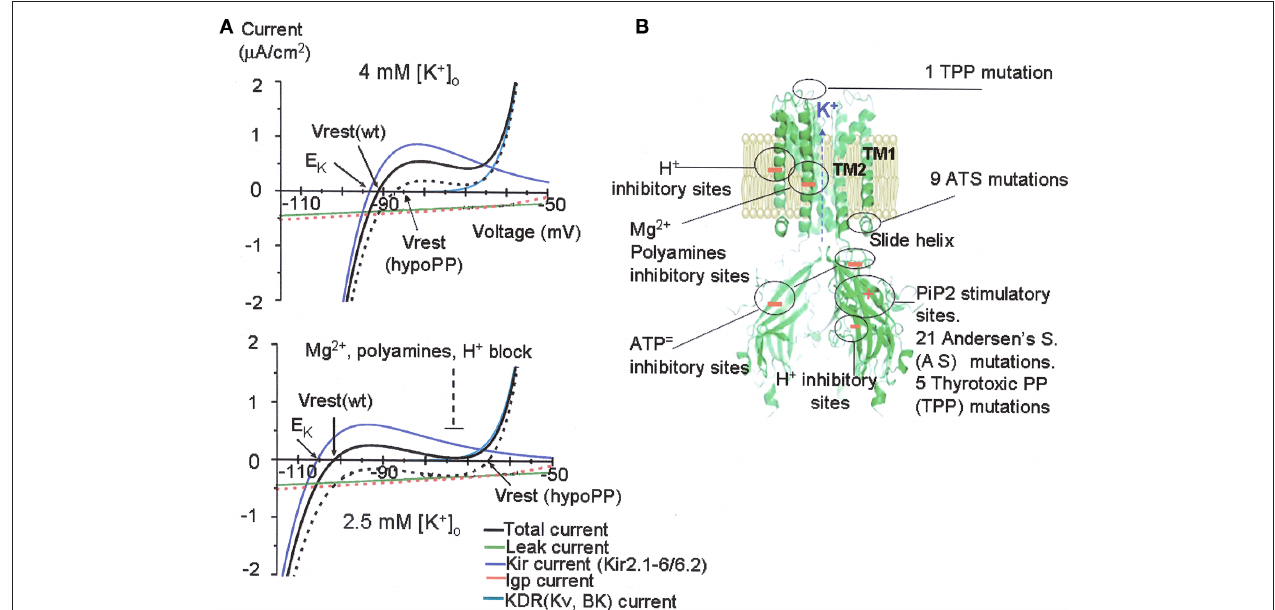
FIGURE 1 | Steady-state I – V relationships simulation in normal and hypoPP and cytoplasmic domains. The NH2 and COOH termini are cytosolic. Tetrameric conditions, and molecular architecture of a Kir channel [modified from assembly of Kir channels. The molecular architecture of a tetrameric Kir channel Kurachi and colleagues (Hibino et al., 2009) and Cannon (2010)]. The I–V (protein database ID 2QKS: Kir3.1–KirBac3.1 chimera) is represented as a relation for mammalian skeletal muscle was simulated by the combination of an cartoon model reproduced and modified from Kurachi and colleagues inward rectifier K + current, I , a delayed rectifier K + current, I , and a leakage Kir KDR current with a reversal potential of 0 mV, I (A) . In 4 mM [K + ]o the resting Leak potential of − 91.3 mV is determined primarily from the balance of an inward I Leak and outward I . Addition of a gating pore current, I , to simulate hypoPP Kir gp (dashed red line), shifts the I – V relation downward (dashed black line) but results in only a small depolarization of V to − 87.3 mV. The reduction of [K + ]o to rest 2.5 mM shifts E and I to more negative potentials, with a predicted K Kir hyperpolarization of V to − 101.6 mV in WT fibers. For hypoPP fibers, however, rest V depolarizes to − 65.3 mV (arrow) because the combination of inward rest currents ( I ) exceeds the outward current from I . Modified from the + I Leak gp Kir original version of Cannon (2010) to evidence that in low external K + ions the affinity of Mg 2 + ions, protons and other endogenous blockers of Kir channels for their inhibitory sites increase leading to the characteristic hump in the I – V relationship of the Kir current component. (B) A schematic representation of the structure of a generic Kir channel. The Kir channel is divided into transmembrane